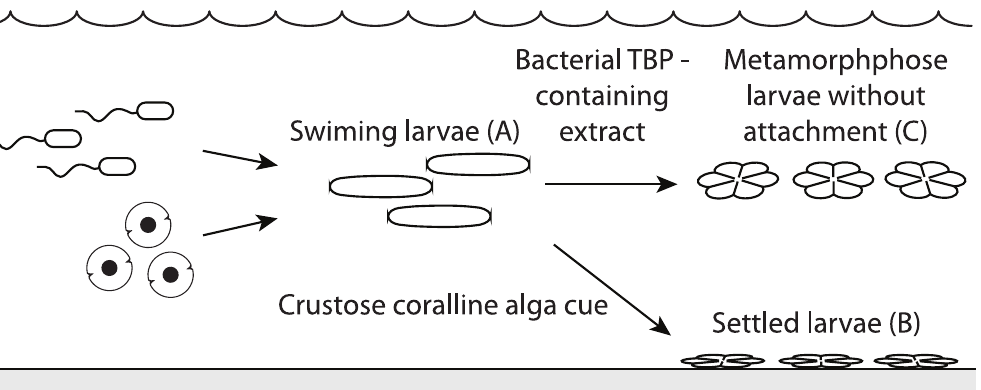
Figure 1. Schematic of coral larval behaviour following exposure to CCA or the bacterial TBP-containing extract. Swimming larvae (A) settle (attach and metamorphose) when exposed to CCA (B) and metamorphose without attachment when exposed to bacterial TBP-containing extract (C).